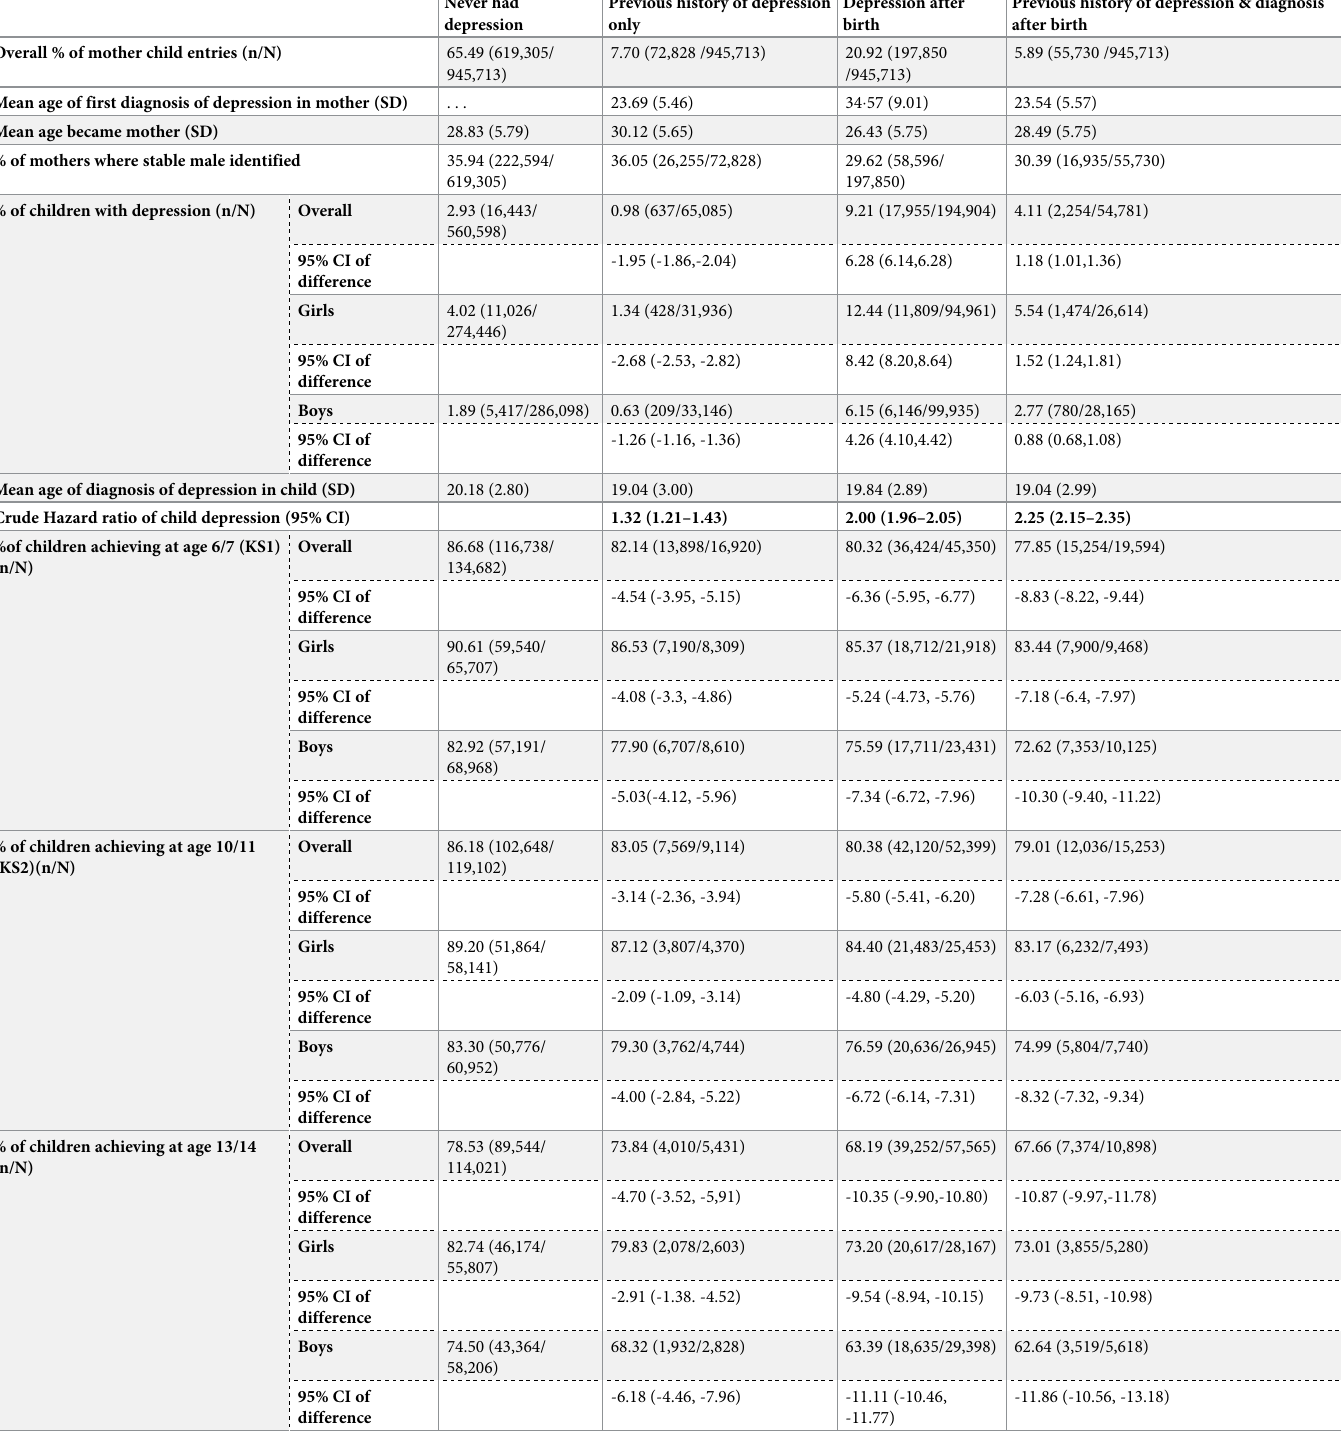
Table 1. Descriptive characteristics of maternal depression, offspring depression and offspring educational